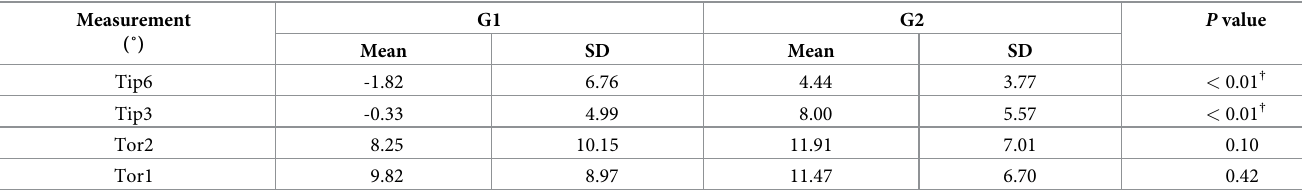
Table 4. Comparison of sagittal angle changes. Measurement (˚)